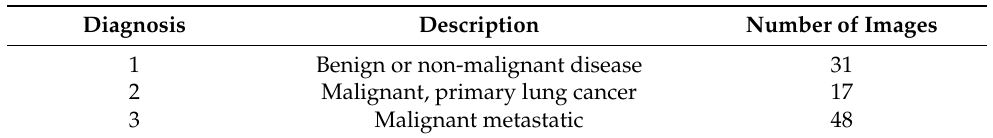
Table 4. LIDC-IDRI patient level diagnosis metadata summary.